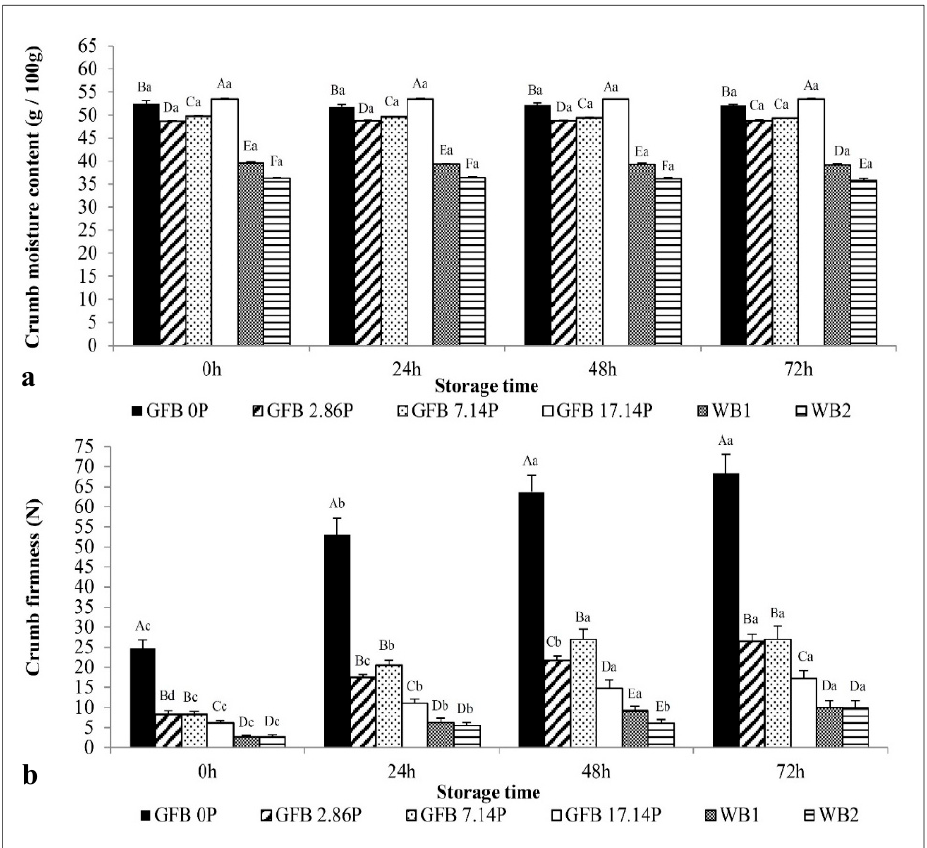
Figure 2. Crumb moisture ( a ) and firmness ( b ) of gluten-free bread (GFB) formulations containing different psyllium levels 0, 24, 48 and 72 h post-production and their comparison to the control and wheat counterparts. The GFBs samples GFB0P, GFB2.86P, GFB7.14P, and GFP17.14P were prepared with 0.00, 2.86, 7.14 and 17.14 psyllium (g/100g flour basis), respectively, and with adjusted water levels. WB1—standard wheat bread formulation, WB 2—adapted wheat bread formulation. Bars represent the mean values (n = 3 for crumb moisture and n = 6 for crumb firmness); error bars represent the standard deviation. Bars with different lowercase letters within the same bread type are significantly different ( p < 0.05). Bars for a given storage time with different capital letters are significantly different ( p < 0.05).